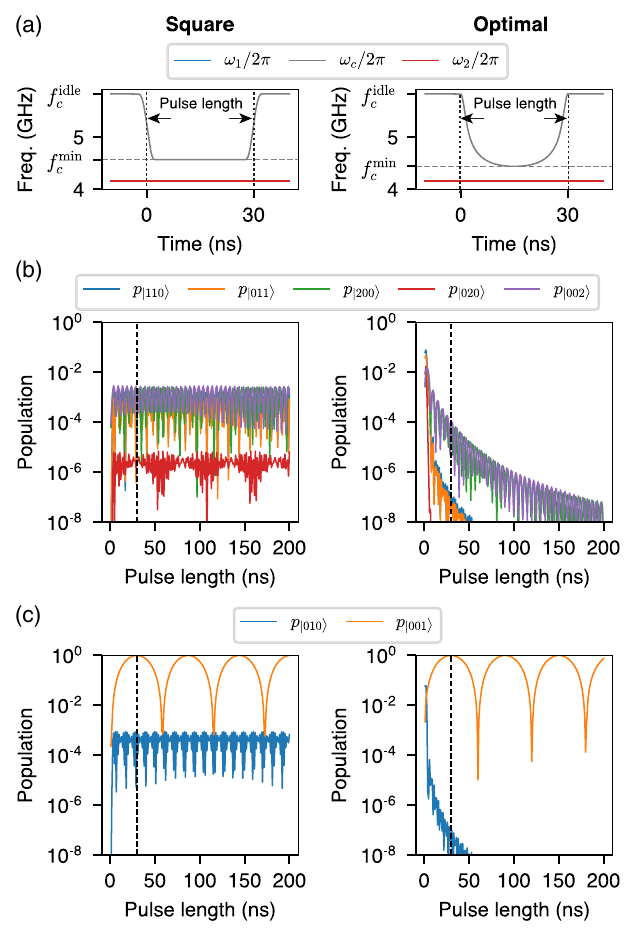
FIG. 19. Numerical simulation of coherent leakage of iSWAP gates. (a) Square-shaped and optimal control waveforms for 30- ns-long iSWAP gates, respectively. (b) Coherent leakage in the double-excitation manifold. We prepare j 101 i , apply a control pulse, and then measure the state populations. By using optimal pulse shaping, we suppress population of the leakage states j 110 i and j 011 i (blue and orange curves) below 10 − 7 for pulses longer than 30 ns (black dashed line). The leakage to j 200 i and j 002 i is not suppressed as much, since the optimal control relies on the effective Hamiltonian H iSWAP ð t Þ that addresses only the leakage eff from j 101 i to j 110 i and j 011 i in the double-excitation manifold. (c) Coherent leakage in the single-excitation manifold. We prepare j 101 i , apply a control pulse, and then measure the state populations. By using the optimal pulse shaping, we suppress population of the leakage state j 010 i (blue curve) below 10 − 7 for pulses longer than 30 ns (black dashed line). The data points in (b),(c) are obtained every 1